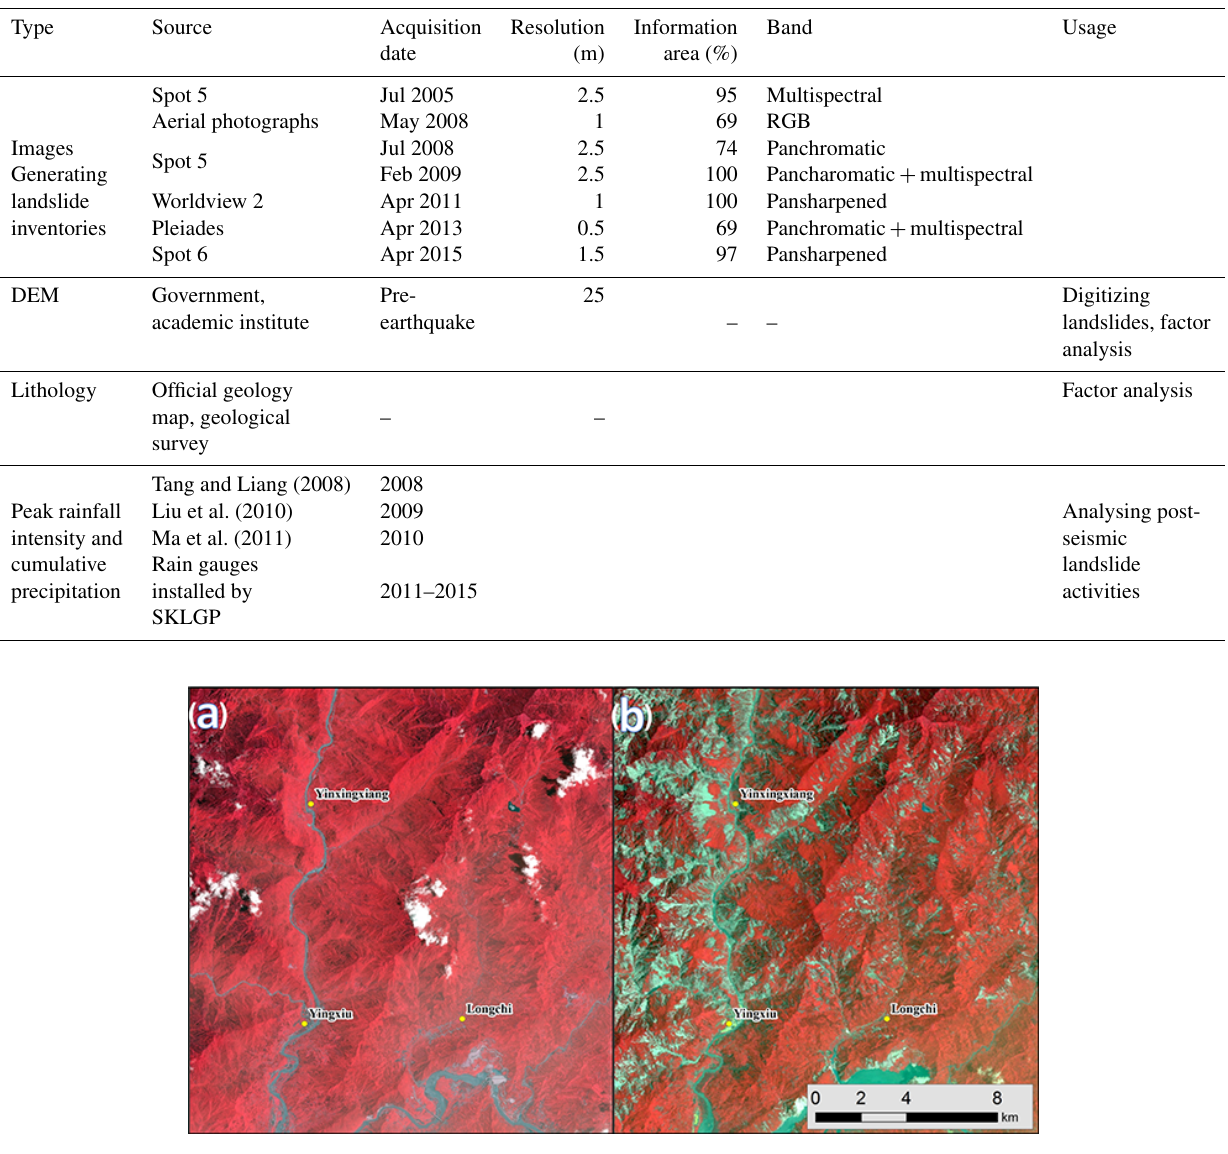
Table 1. Data used in this research. The two images taken in 2008 have 7% of the study area covered by clouds on both images. The other images are cloud free. Information area (%) represents the percentage of the area not covered by clouds and the inside of the image boundaries.